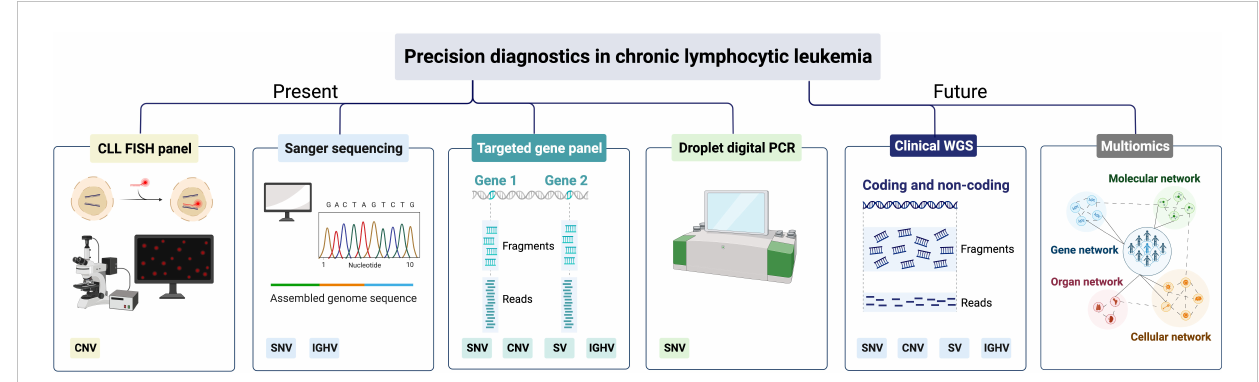
FIGURE 4 Precision diagnostics in CLL, present status and future directions. SNV, single-nucleotide variants; CNV, copy-number variants; SV, structural variants; IGHV, immunoglobulin heavy